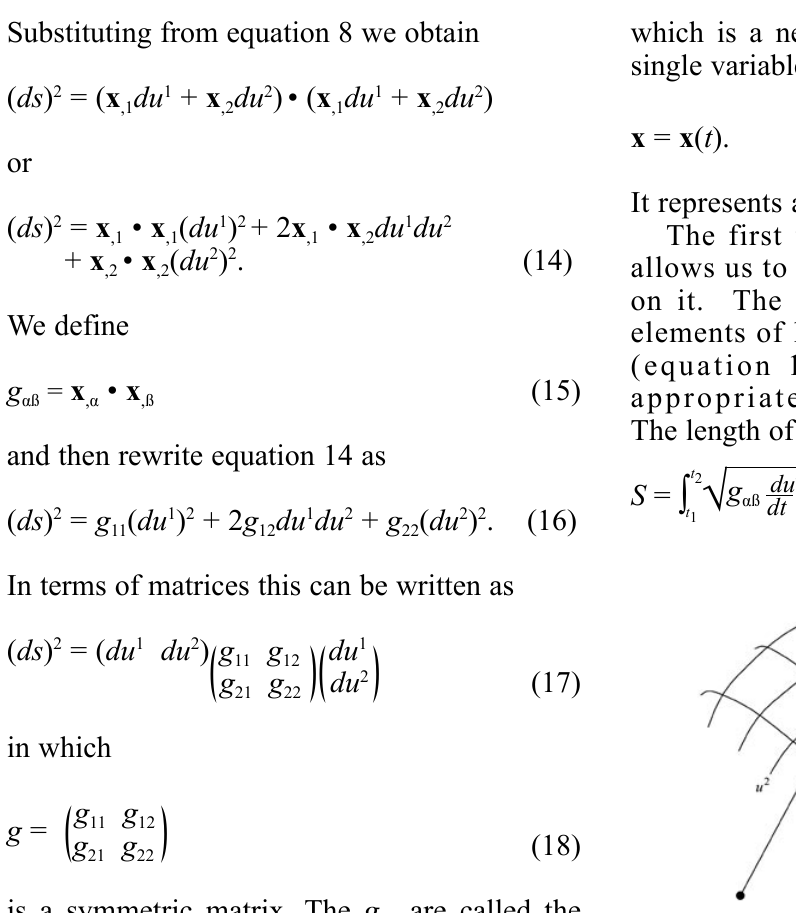
Figure 5 A curve (equation 21) on a